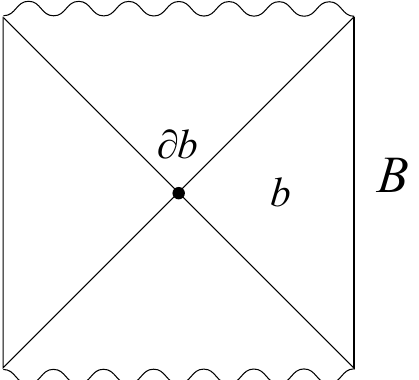
Figure 1 . When the boundary region B is the right asymptotic boundary of a two-sided black hole, the entanglement wedge b is simply the right exterior of the black hole. The entanglement entropy of B is given by the generalized entropy S gen ( b ) = A ( ∂b ) / 4 G + S bulk ( b ) where A ( ∂b ) is the area of the black hole bifurcation surface and S bulk ( b ) is the entanglement entropy of bulk quantum fields in the right